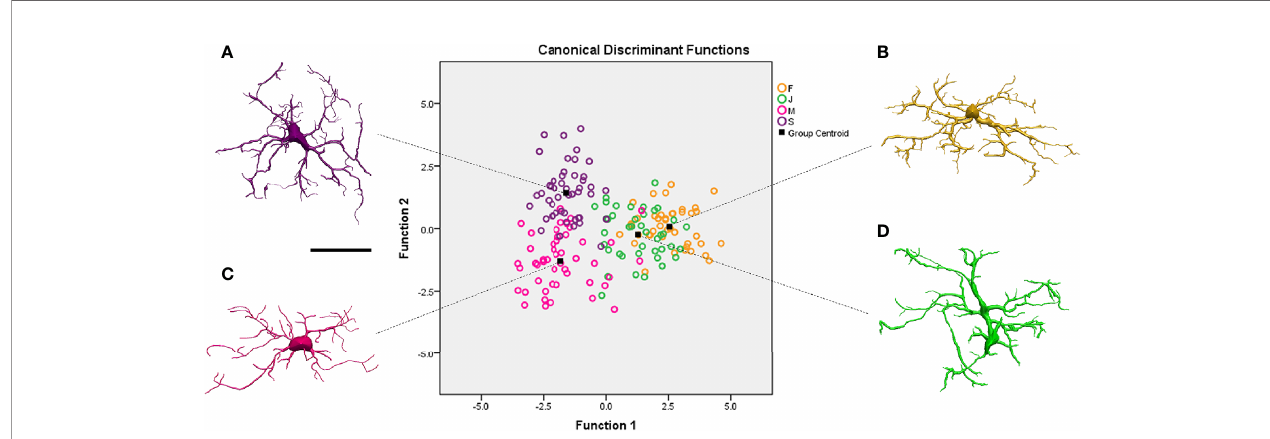
FIGURE 4 | Graphical representation of the canonical discriminant function analysis of the morphometric characteristics of microglia obtained from three-dimensional reconstructions performed on the molecular layer of the rostral dentate gyrus of 4 individual capuchin monkeys ( Sapajus apella ): M, S, F and (J). Open circles of different colors illustrate the distribution of the microglia of each individual in the Euclidean space. Microglia of S (A) and M (C) with better learning rates occupy distinct regions in the left quadrants of the Euclidean space, while F (B) and J (D) individuals with lower learning rates share similar regions in the right quadrants of the Euclidean space. Function 1 and 2 explain 84.2% of variance (for statistical details see Suplemmentary Material SM2 ). Scale bar = 25